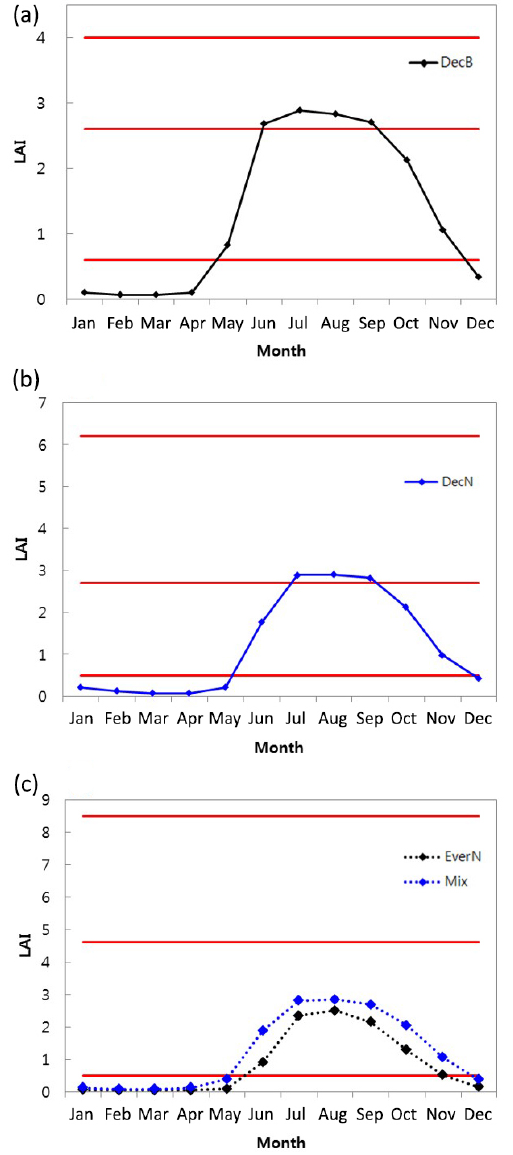
Figure 3. Monthly averaged LAI in the Noah-MP during the period of 2001–2010 for (a) deciduous broadleaf forest (DecB), (b) de- ciduous needleleaf forest (DecN), (c) evergreen needleleaf forest (EverN), and mixed forest (Mix). The red lines represent the mini- mum, mean, and maximum LAI of the reference values. In (c) , the reference values are shown only for EverN.